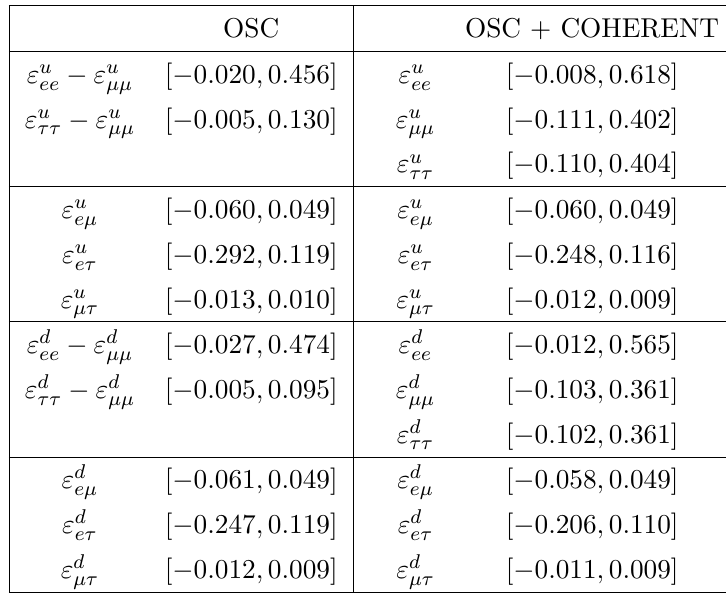
and " d , at 2 (cid:27) C.L., obtained from the (cid:11)(cid:12) (cid:11)(cid:12)